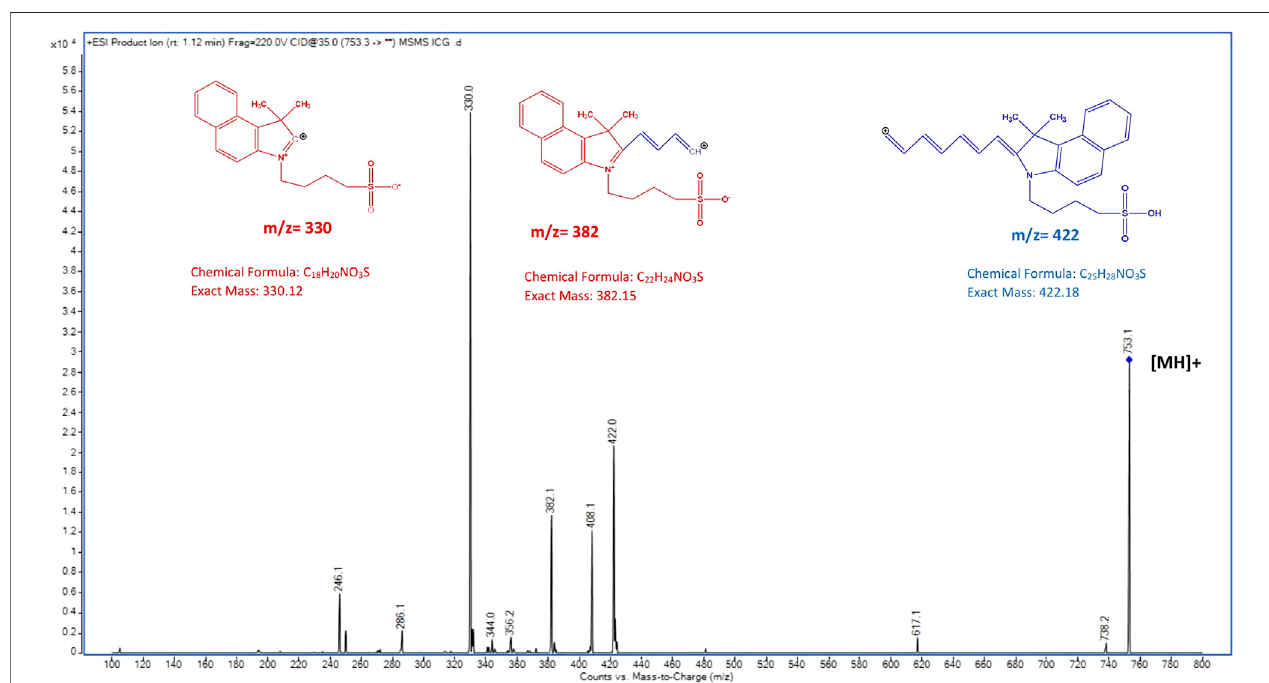
FIGURE 2 | Product ion mass spectrum of ICG obtained with electrospray ionization, positive